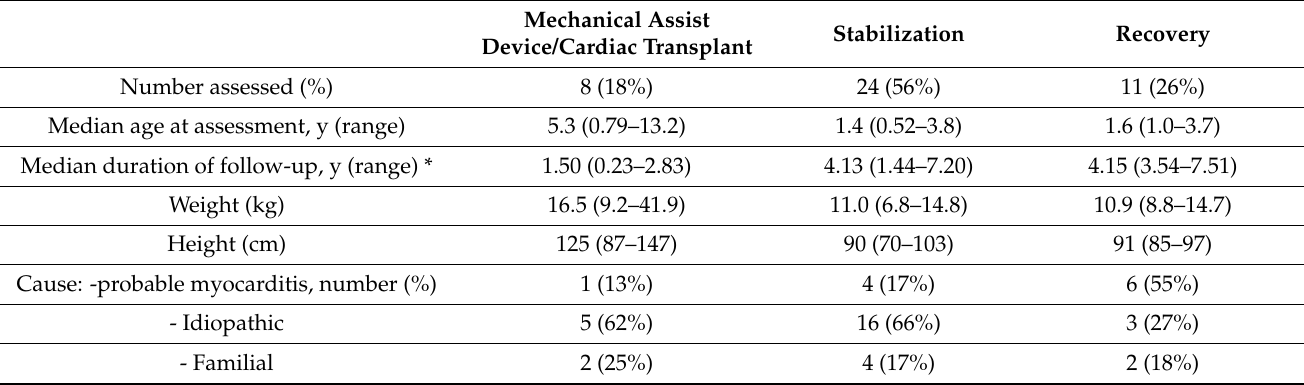
Table 1. Clinical Table 1. Clinical characteristics.